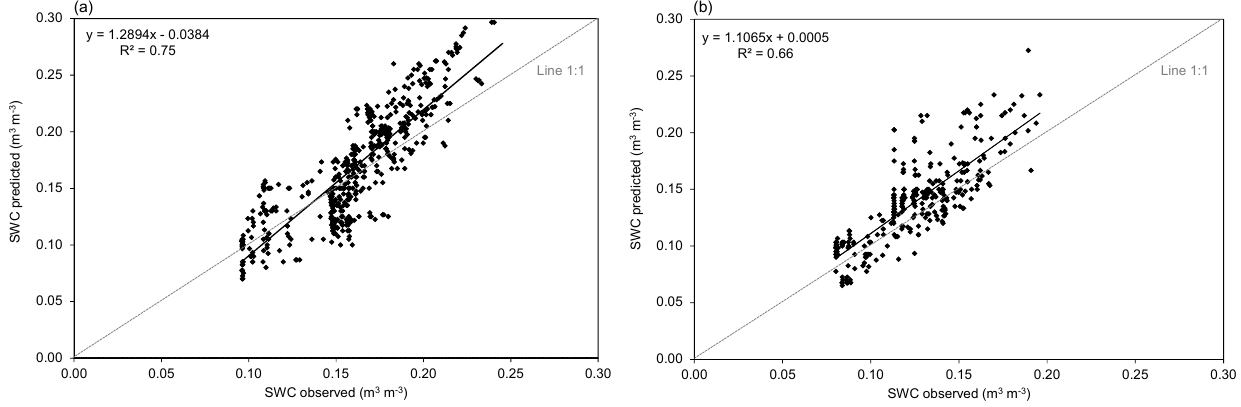
Figure 10. Linear regression between observed and predicted data as a result of ( a ) model inversion and ( b ) validation.